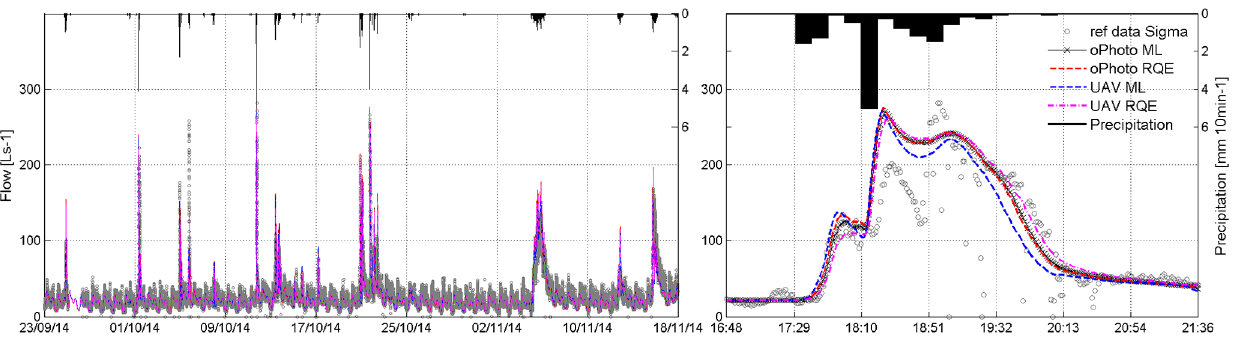
Figure 8. Observed reference and simulations (prior calibration) for the full validation period September to November 2014 (left panels) and a selected event on 11 October 2014 (right panels).